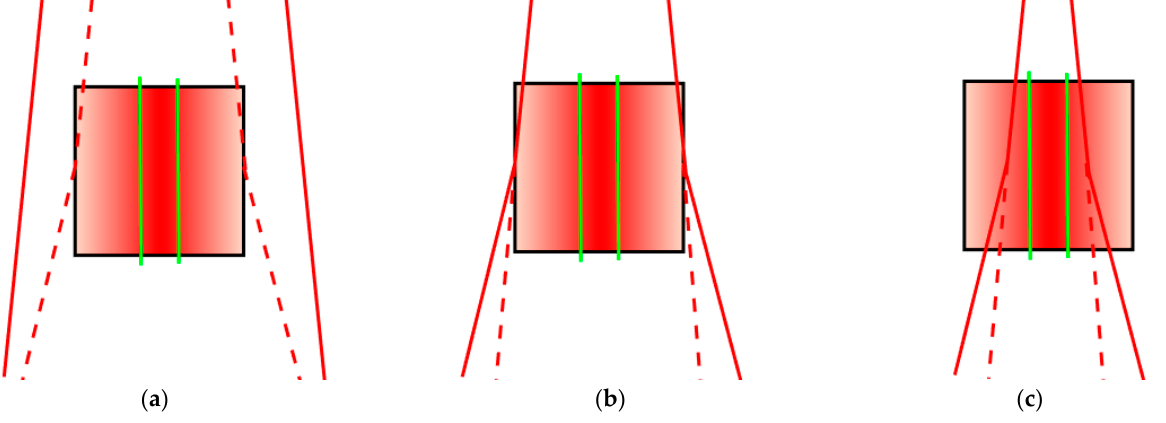
Figure 13. Schematic representation of excitation (boundaries are green lines) and probe beams (boundaries are red lines; dashed lines denote the boundaries without a thermal-lens effect) through the sample in a thermal-lens experiment. The red-to-white gradient denotes the thermally induced field in the sample (the thermal-lens effect). ( a ) The probe beam is too broad, and only the central part broadens due to the thermal-lens effect and interferes with the undisturbed part at the detector plane (not shown here for simplicity’s sake); ( b ) the correct size of the probe beam, so it is almost equal to the size of the photothermal field (thermal lens); and ( c ) the probe beam is too narrow, and it does not probe the whole thermal field, degrading the sensitivity of measurements.